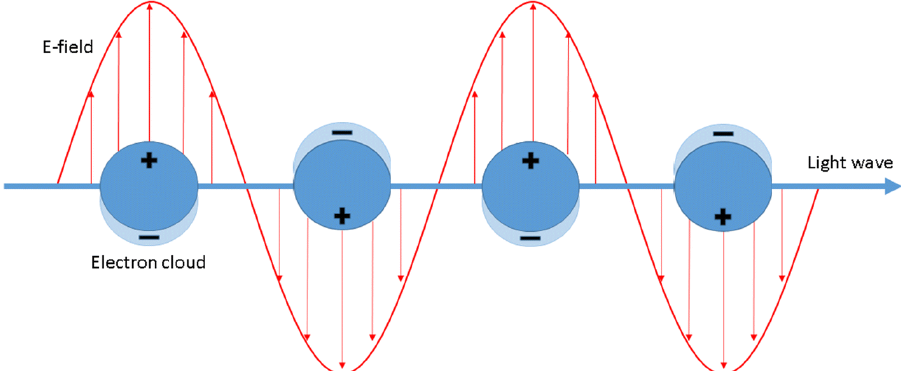
Figure 1. Schematic illustration of the surface plasmon resonance (SPR) phenomenon. Reproduced with permission [6]. Copyright, 2020, Springer Nature.